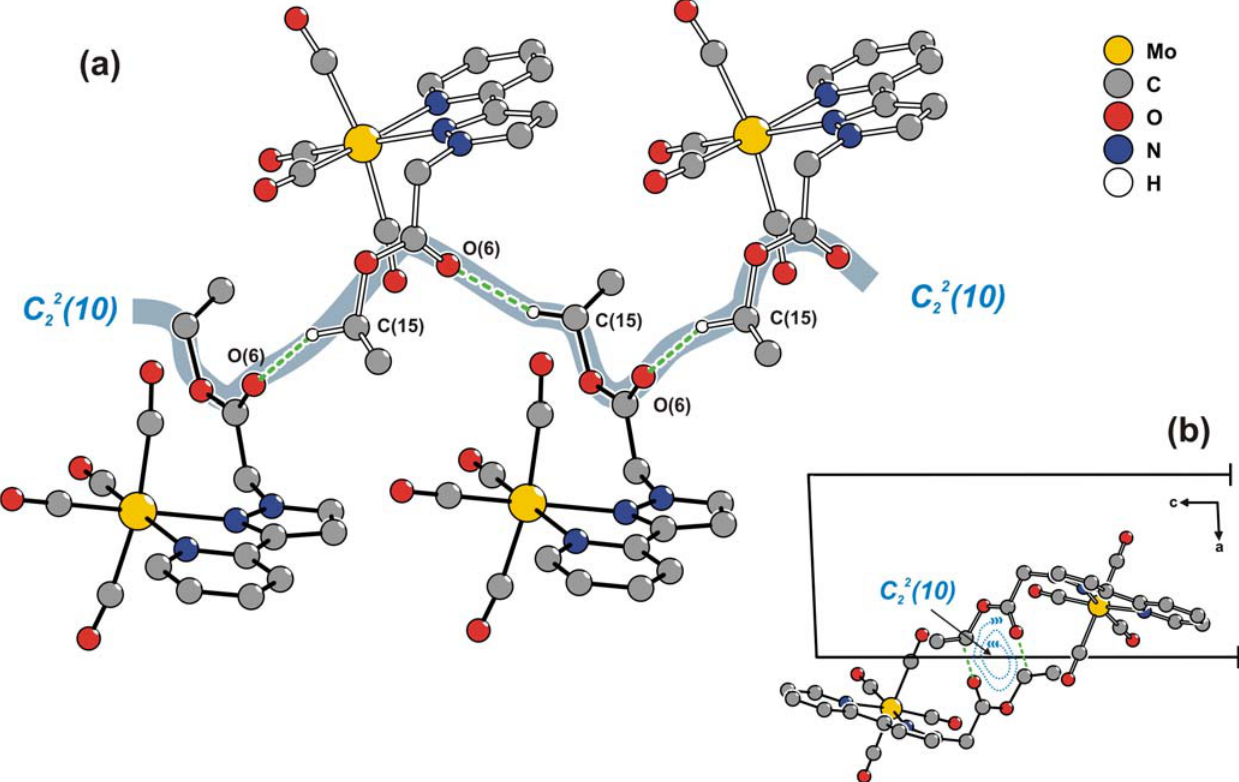
Figure 3. Schematic representation emphasising the C 22 (10) chain of weak C–H···O hydrogen bonding interactions (represented as dashed green lines) running along the [010] direction of the unit cell. These bonds interconnect individual cis -[Mo(CO) (pzpy)] complexes belonging to different, but adjacent, one- 4 dimensional supramolecular tapes (represented with white- and black-filled bonds for each tape). Hydrogen atoms which are not involved in C–H···O hydrogen bonding interactions and all symmetry codes related to symmetry- generated atoms have been omitted for